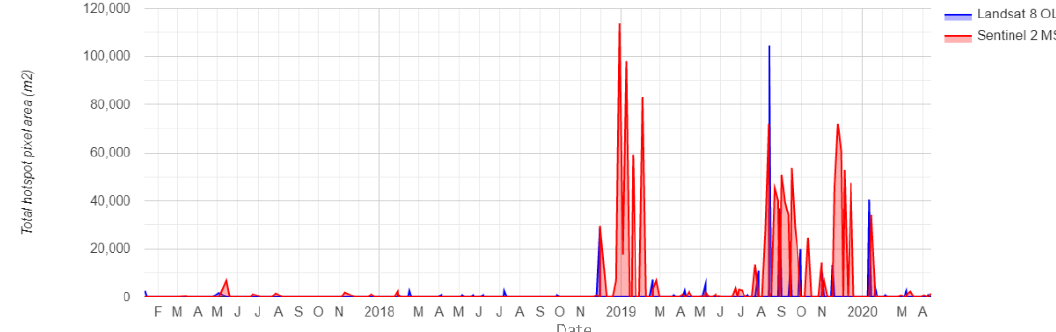
Figure 6. Plot of total hot spot area retrieved at Karangetang (Indonesia), referring to the same time- period of Figure 5. The plot was generated offline integrating Sentinel-2 MSI (red curve) and Landsat- 8 OLI (blue curve) observations. Landsat-8 OLI (blue curve)